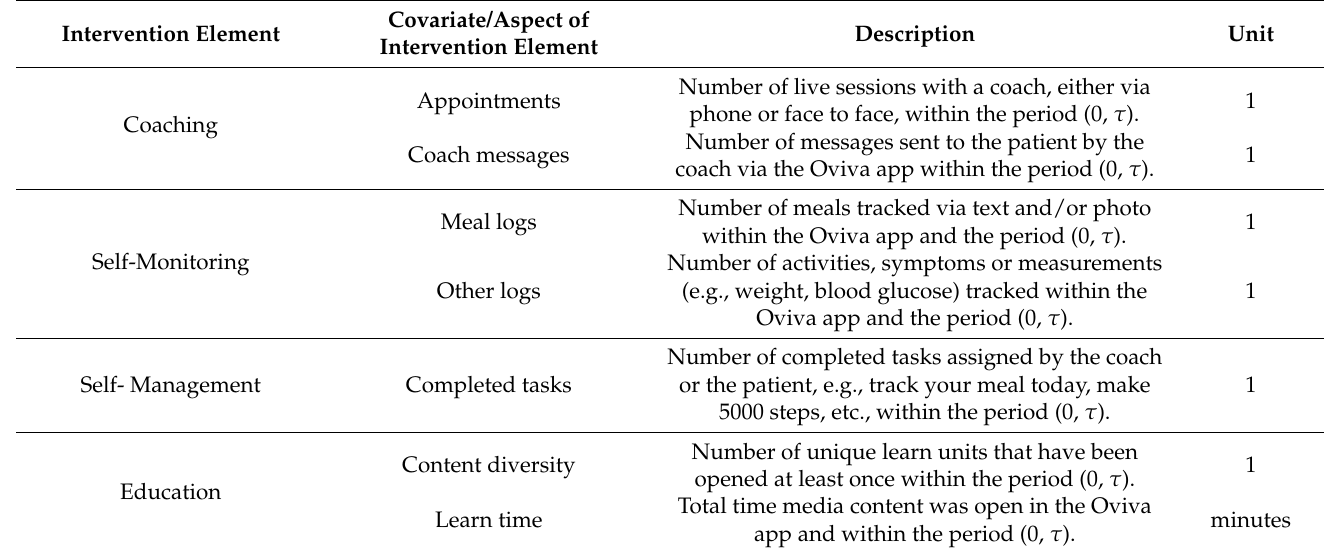
Table 1. Description of independent variables used in the multiple